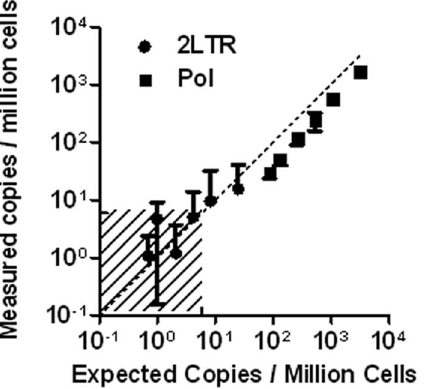
Figure 5. Assay limit of detection and quantification. CD4 cells infected in vitro were serially diluted into a background of PBMC DNA. The number of replicate wells was increased from 3 to 36 in proportion to the dilution, allowing accurate measurement below one copy per 10 6 cells. The shaded area indicates concentrations below the theoretical limit of detection for a single well.